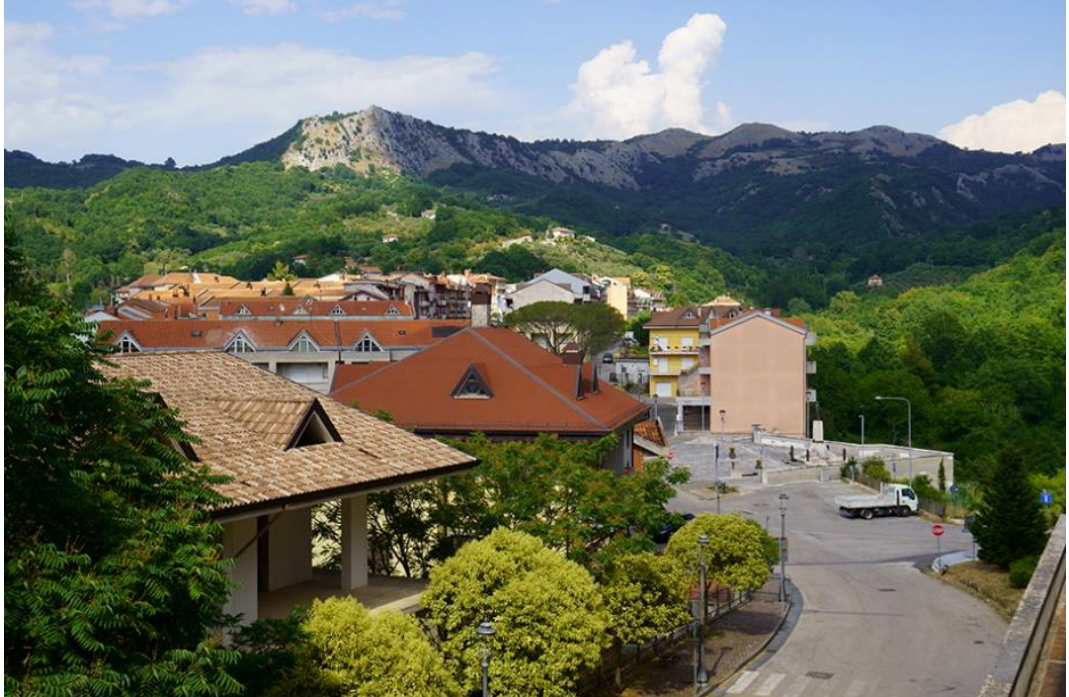
Figure 19. Laviano: the village completely rebuilt after the 1980 earthquake (photos by [35,36]).